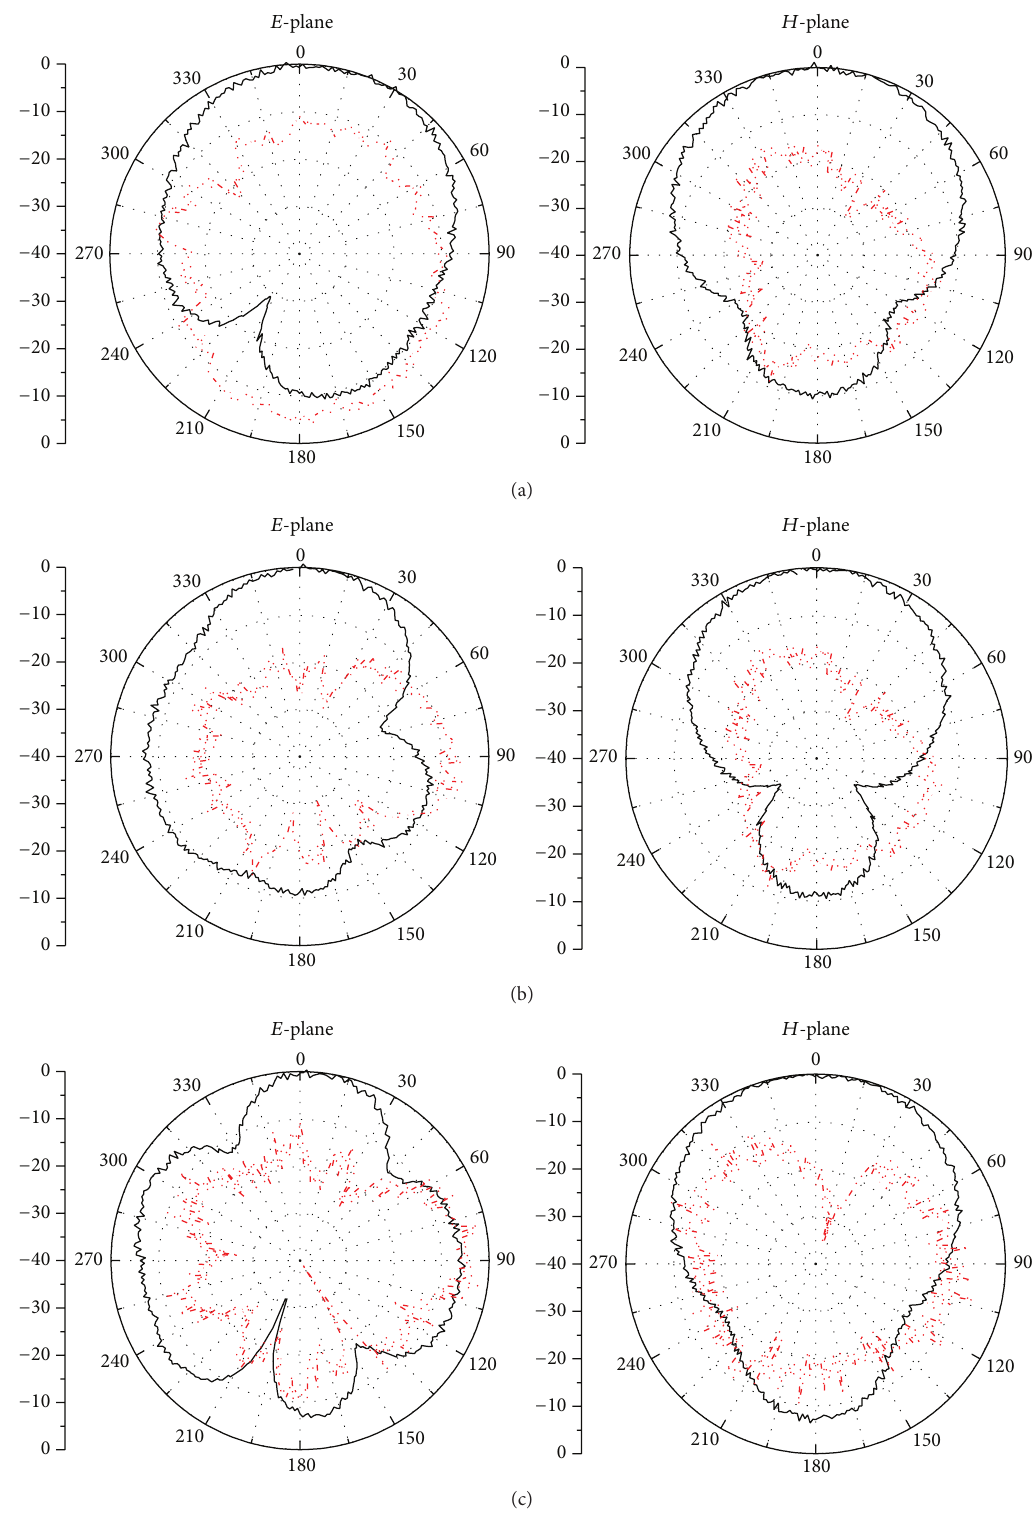
Figure 11: Measured normalized radiation patterns of the proposed DRA. (a) 3.0 GHz, (b) 5.0 GHz, and (c) 6.5